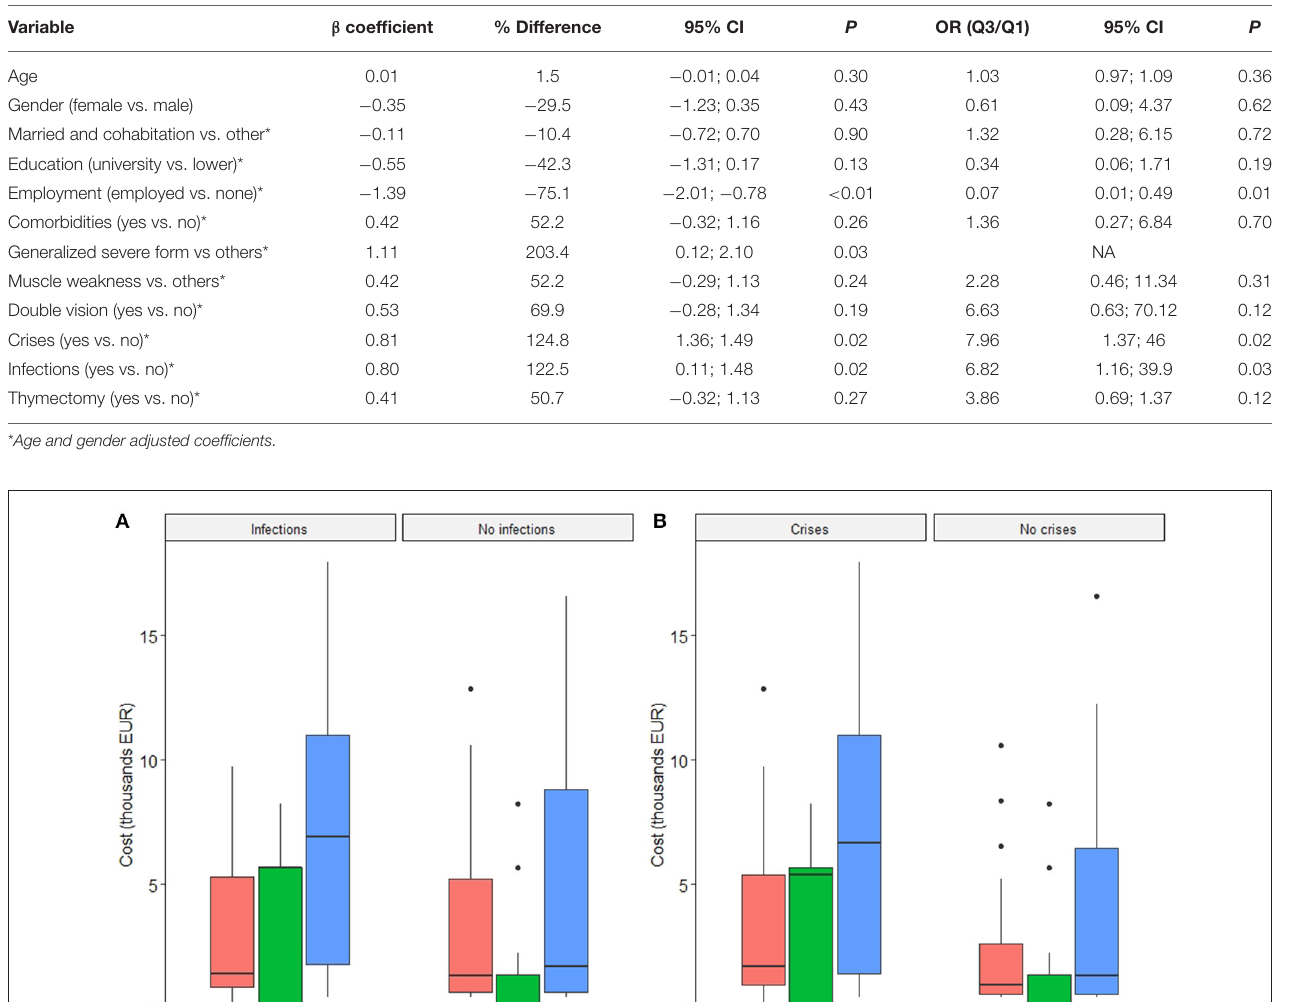
not covered either. This has important implications for